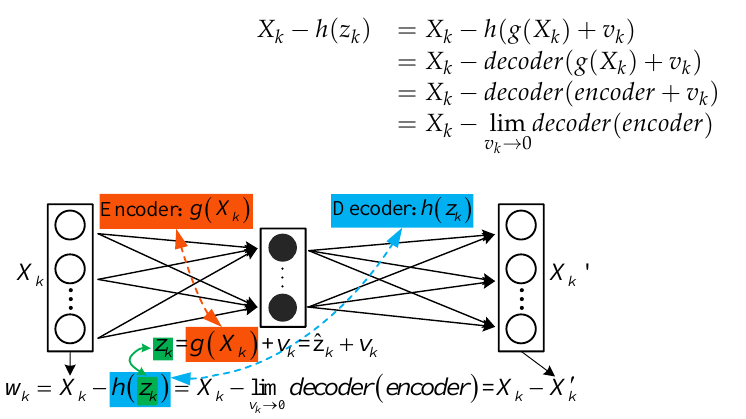
X h z − by auto-encoder. Figure A1. Description of X − h ( z ) by auto-encoder. k k k k = arg max P ( X ) can be solved by auto-encoders, | z k k k , MLE